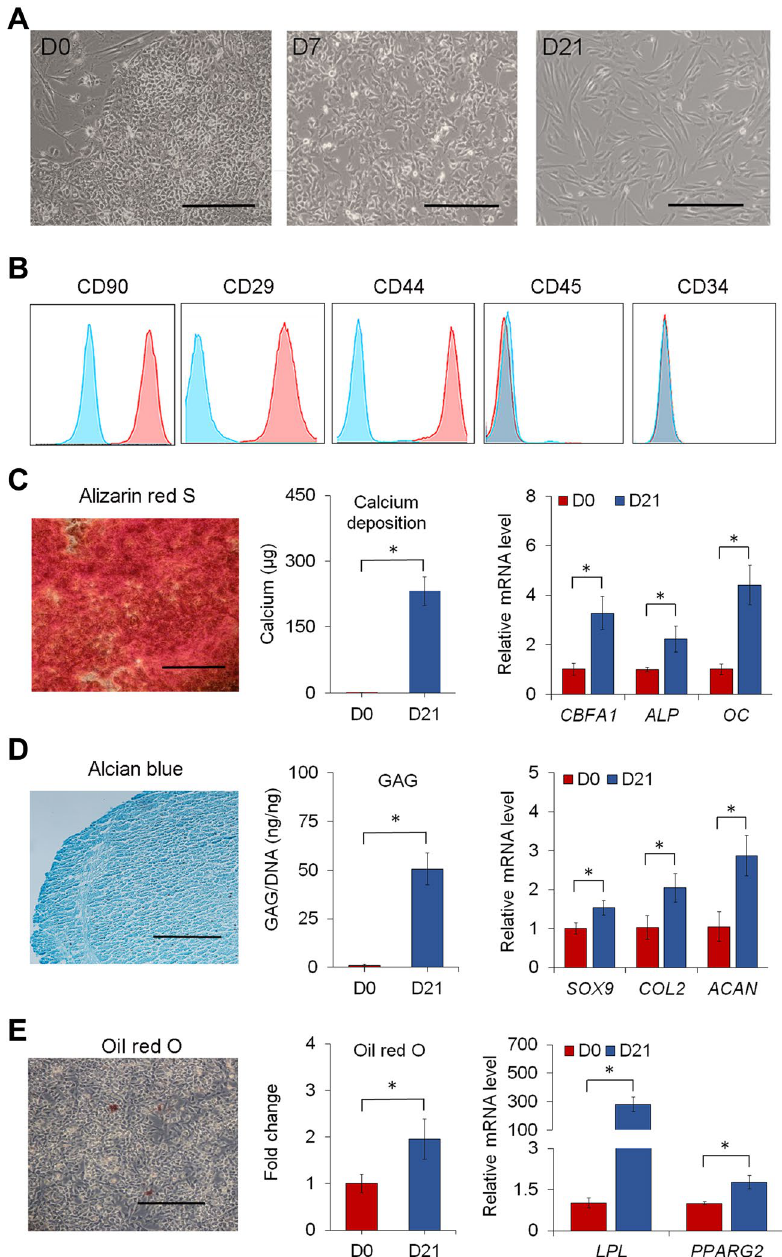
Figure 4. Derivation and characterization of iPSC-MSCs. ( A ) Phase-contrast images of cells in iPSC culture induced for 21 days of MSC differentiation. ( B ) Expression of surface markers on iPSC-MSCs. Pink histograms represent surface markers of interest. Blue histograms represent isotype controls. ( C ) Alizarin red S staining, quantification of calcium deposition, and relative mRNA levels of the bone-associated markers CBFA1 , ALP, and OC in cells differentiated from iPSC-MSCs after 21 days of osteogenesis. ( D ) Alcian blue staining, quantification of GAG production, and relative mRNA levels of the cartilage-associated markers SOX9 , COL2 , and ACAN in cells differentiated from iPSC-MSCs after 21 days of chondrogenesis. ( E ) Oil red O staining, quantification of lipid droplets, and relative mRNA levels of the fat-associated markers LPL and PPARG2 in cells differentiated from iPSC-MSCs after 21 days of adipogenesis. Scale bar = 200 µm. * p < 0.05; n =